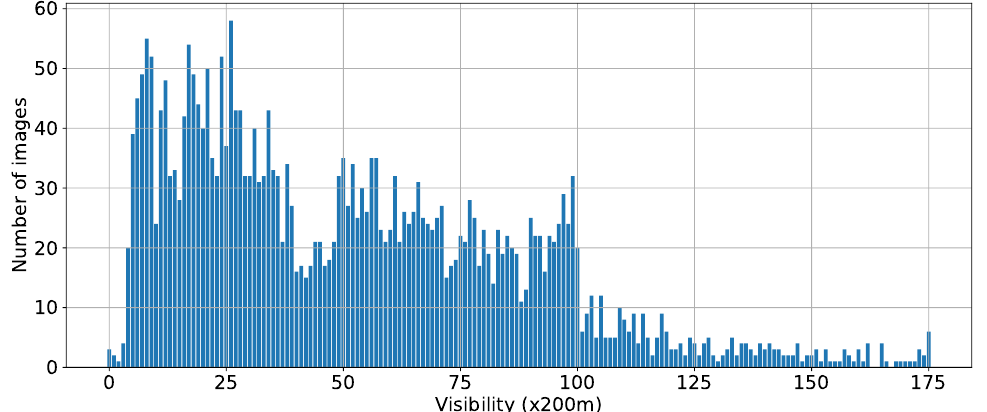
Figure 1. Visibility distribution of QVEData. (Note × 200 m denotes the unit of the x-axis. In other words, if x = 25, then the visibility is actually 25 × 200 m = 5000 m.)